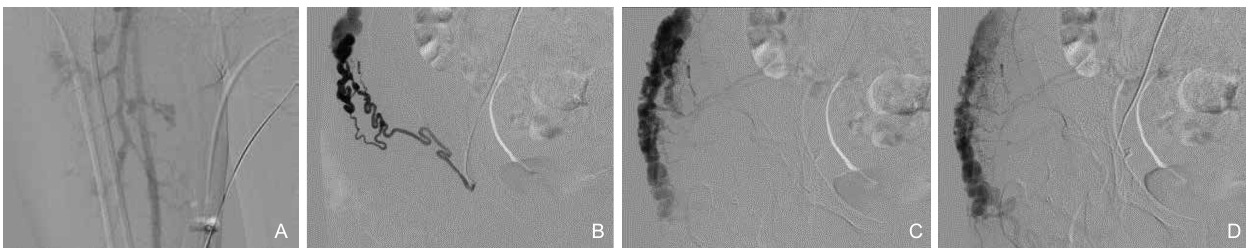
Figure 2 Digital subtraction angiography (DSA) demonstrated arteriovenous fistulas in the right lower limb (A). The vessel separated from the trunk of the lower extremity artery and extended subcutaneously (B). The abnormal vessel became large and tortuous in subcutaneous tissues (C), branching off and finally draining into the veins (D).